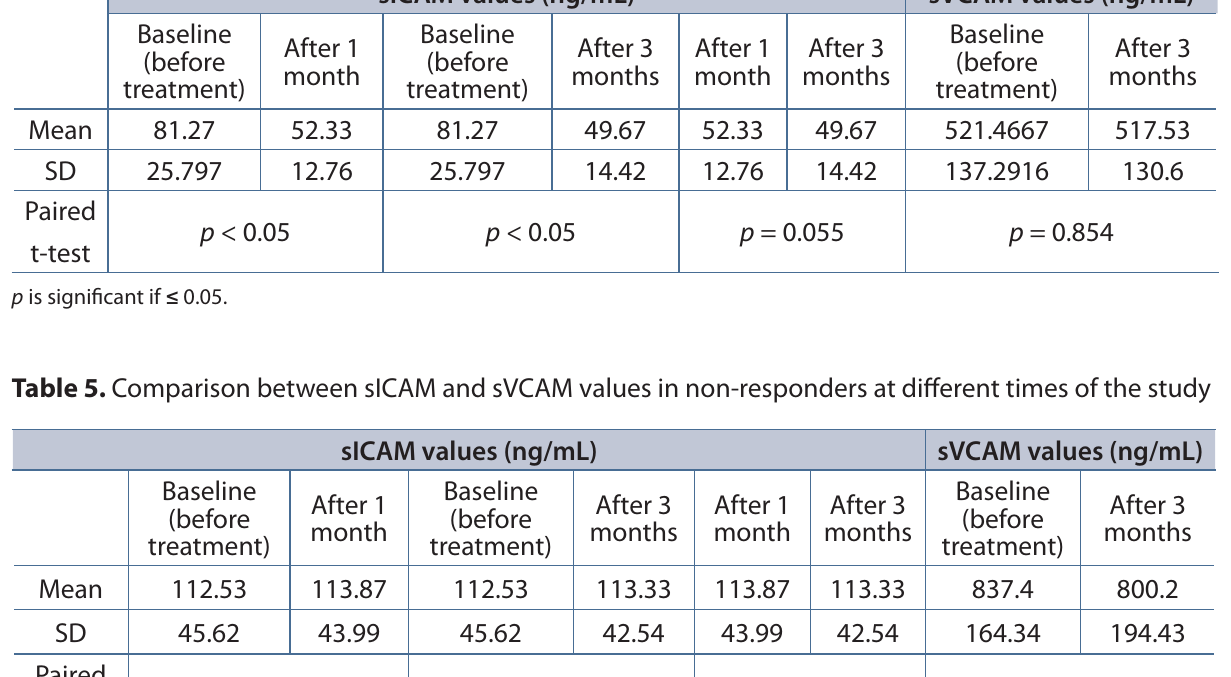
Table 4. Comparison between sICAM and sVCAM values in responsive patients at different times of the study